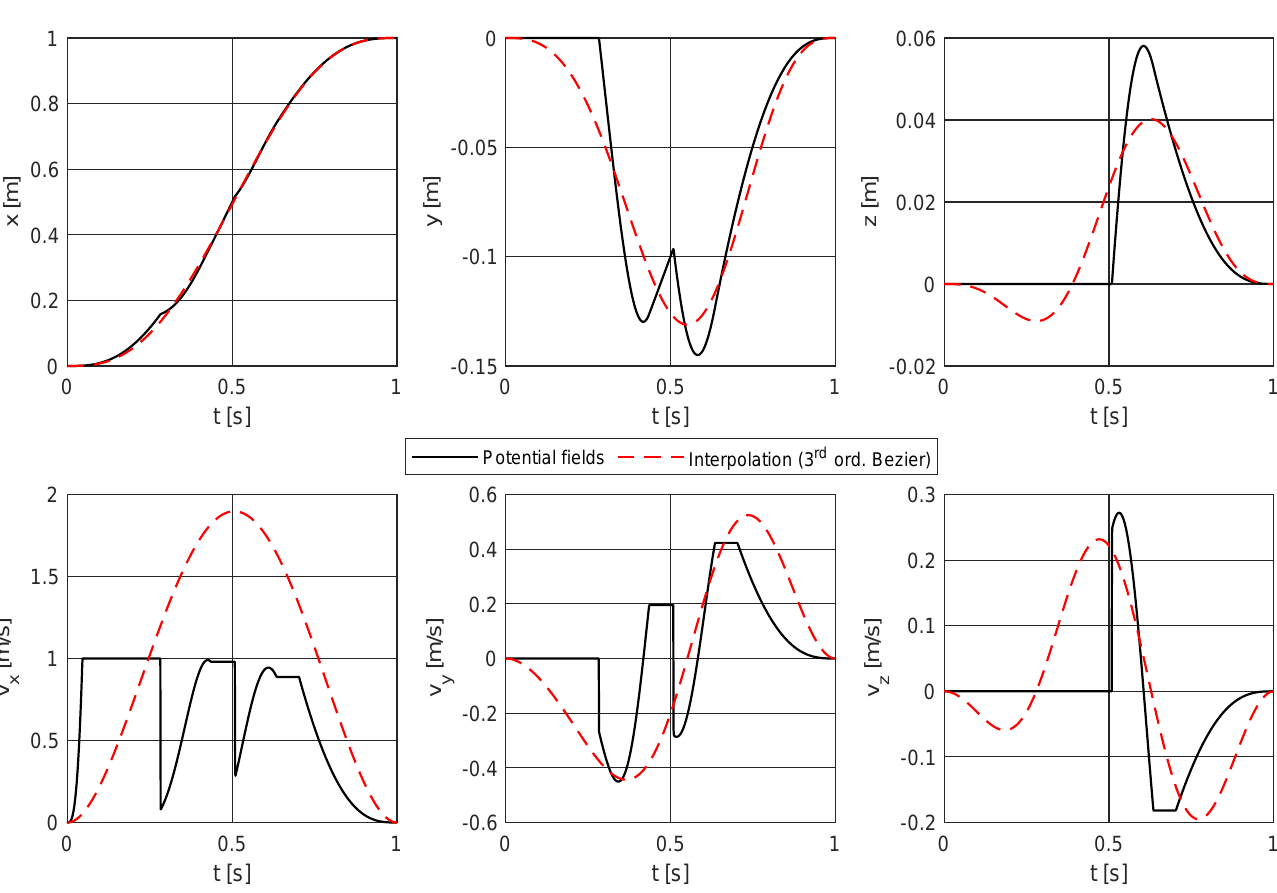
Figure 3. Comparison between position and velocity profiles of potential fields trajectory and smoothed trajectory related to the example of Figure 2.